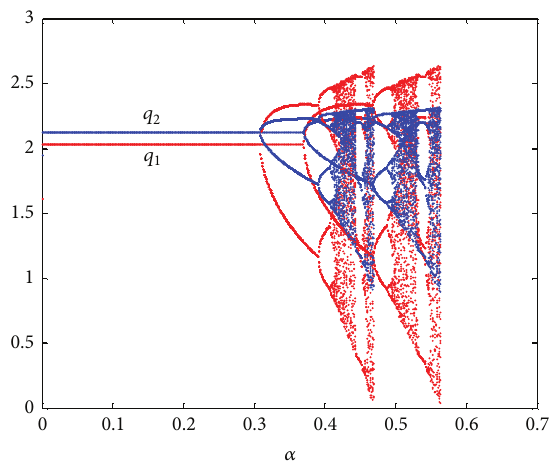
Figure 7: The bifurcation diagram with respect to the controlling factor 𝑘 with the parameter 𝛼 = 0.46 .